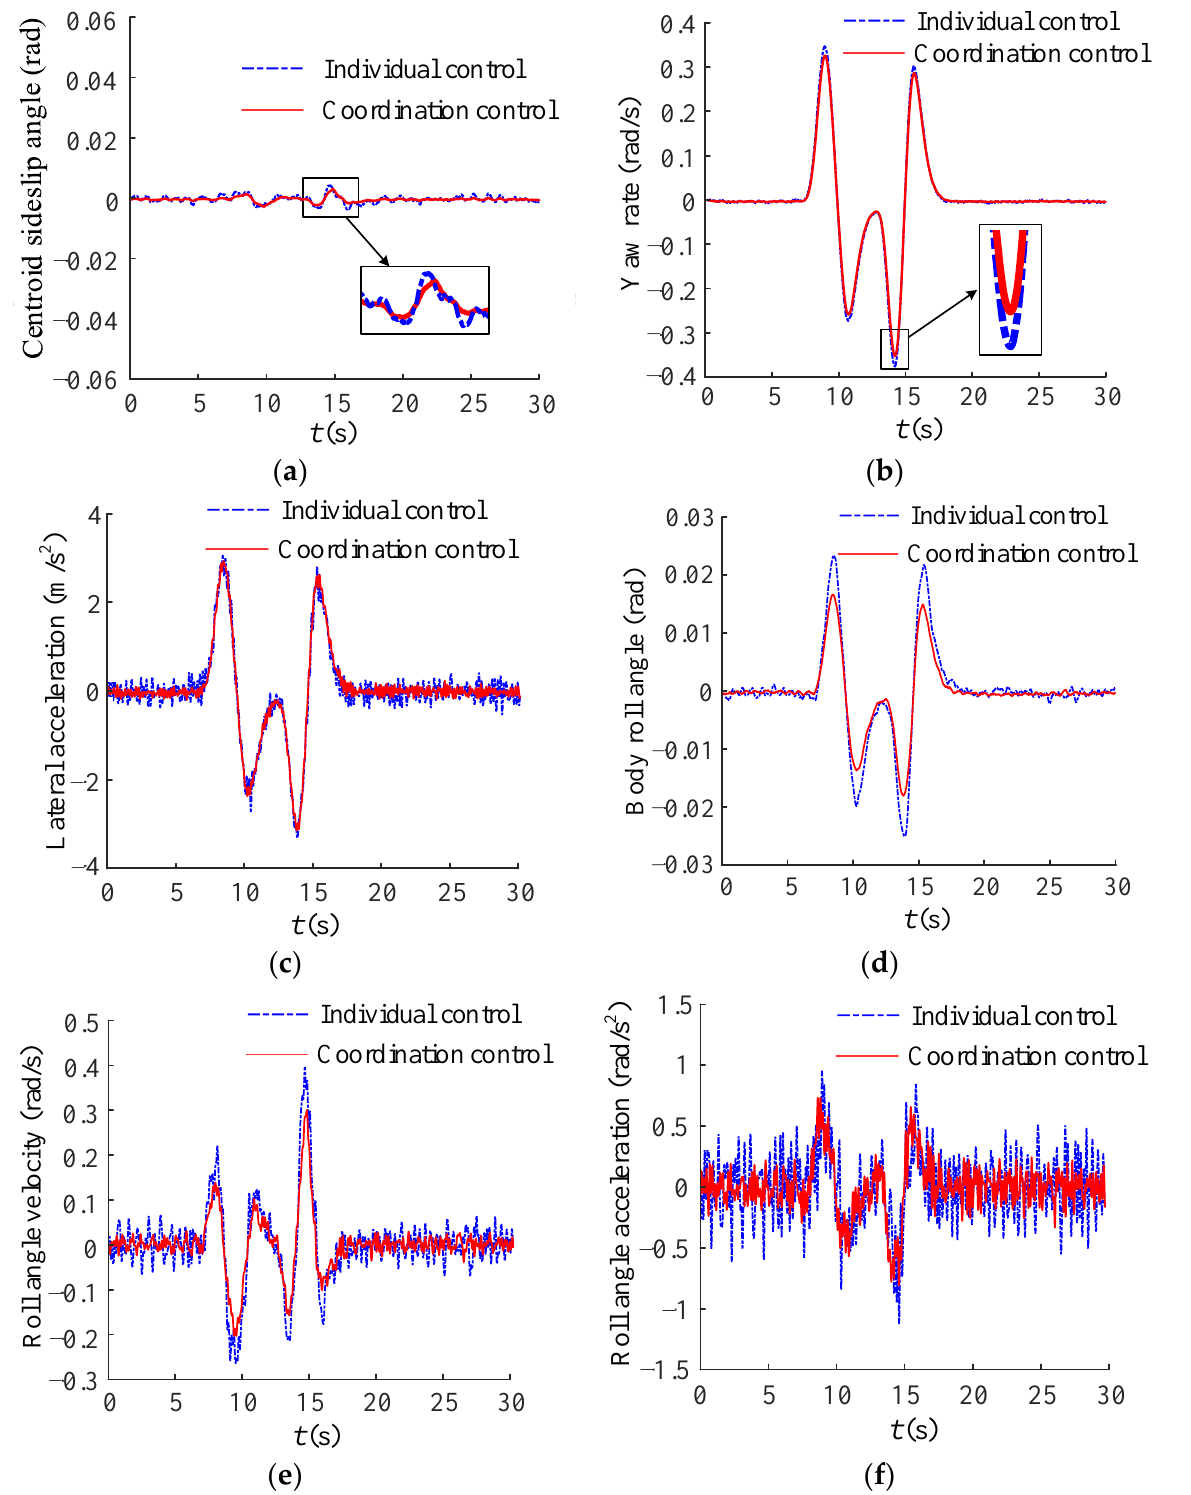
Figure 7. Response curves under double line change conditions: ( a ) centroid sideslip angle; ( b ) yaw